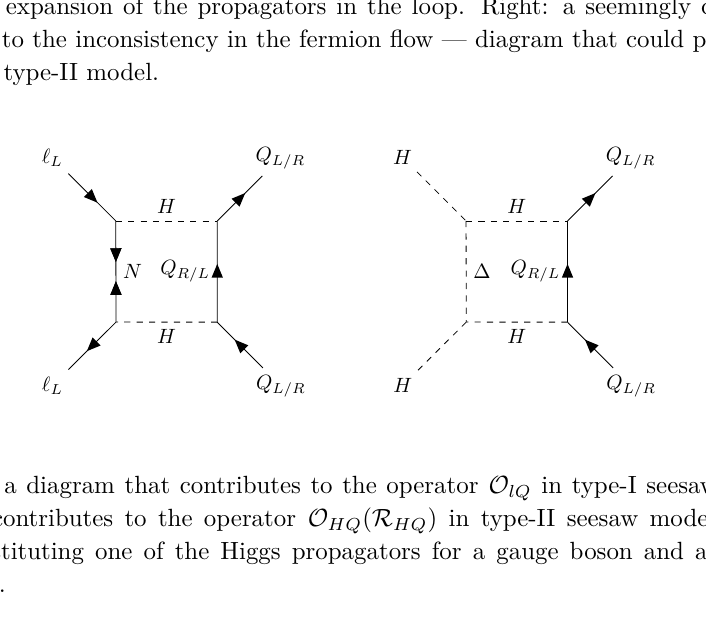
¯ ‘ L e R H, O eX , R eHDn in the type-I and covariant derivatives in R are originated eX eHDn